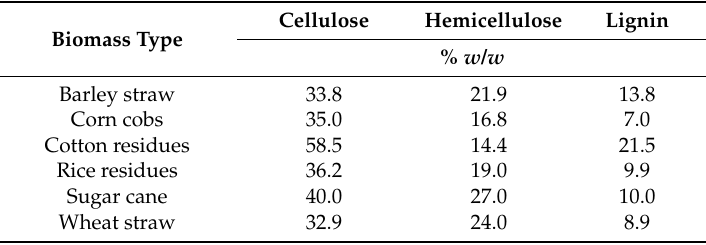
Table 2. Average shares of main components of selected lignocellulosic biomass materials in selected raw materials